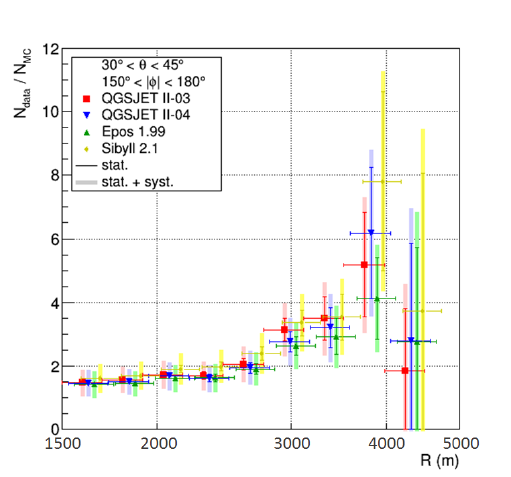
Figure 10. Data / MC ratio of signal size as a function of R for various hadronic interaction models. (Figure from